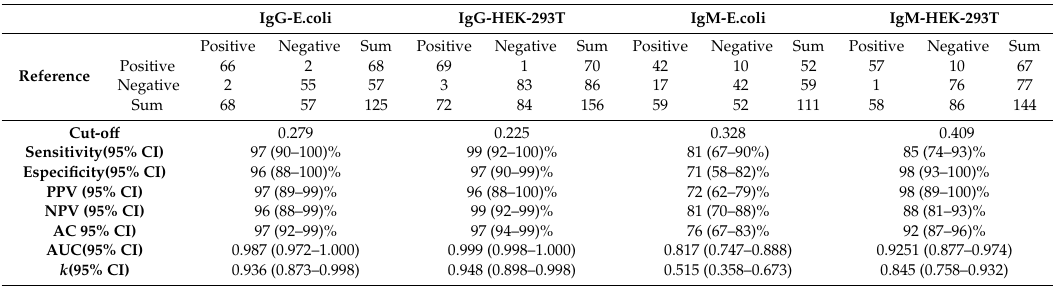
Table1. Di ff erentparameterstoevaluatethediagnosticperformanceofELISAteststodetectanti-CHIKV antibodies employing either prokaryotic-made or eukaryotic-made E2